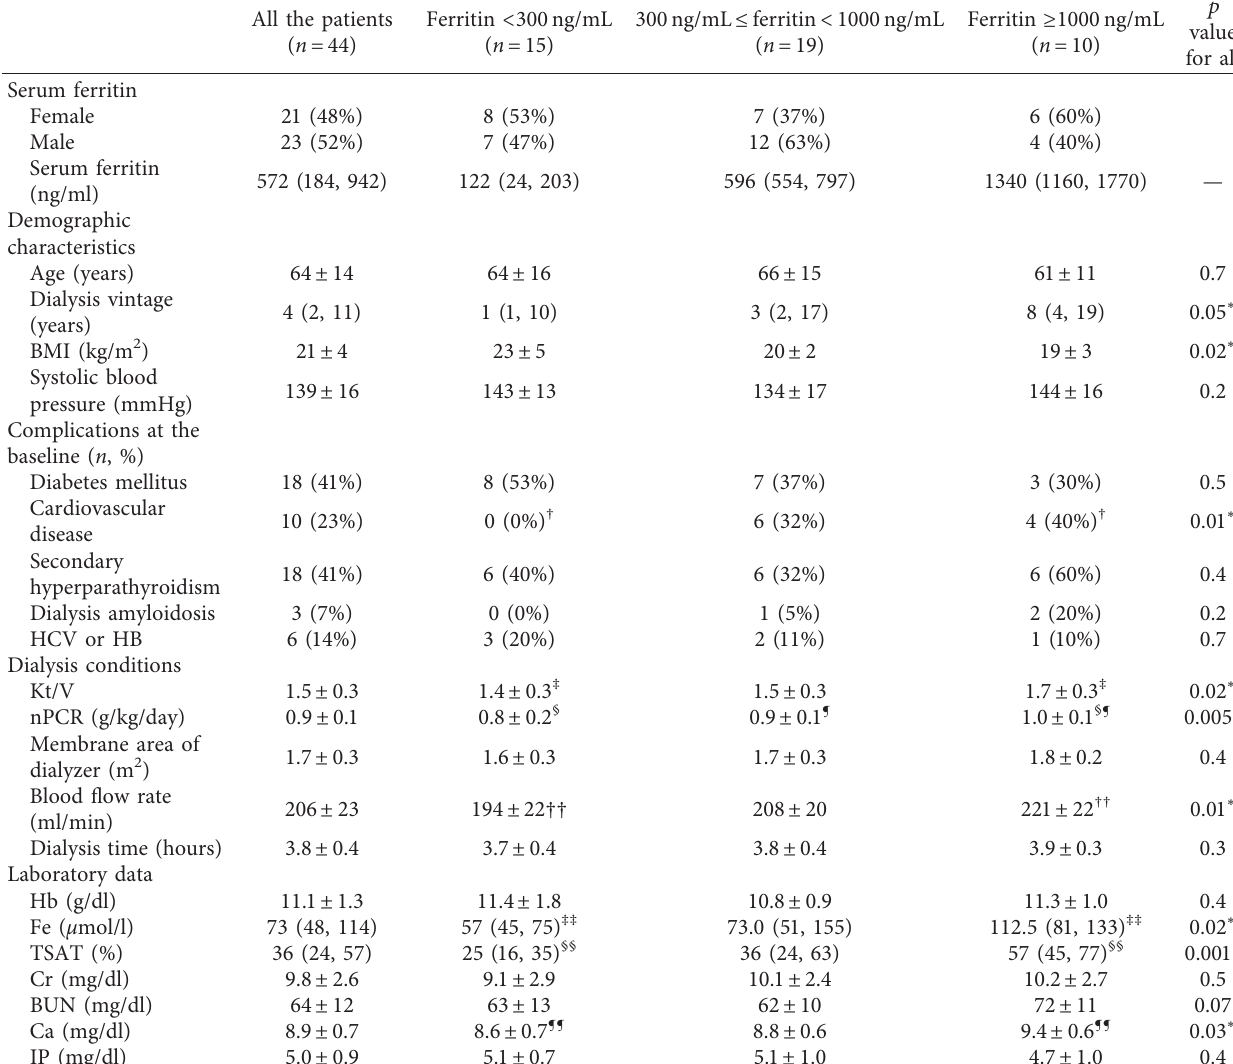
Table 1: Baseline data of all patients based on serum ferritin levels in